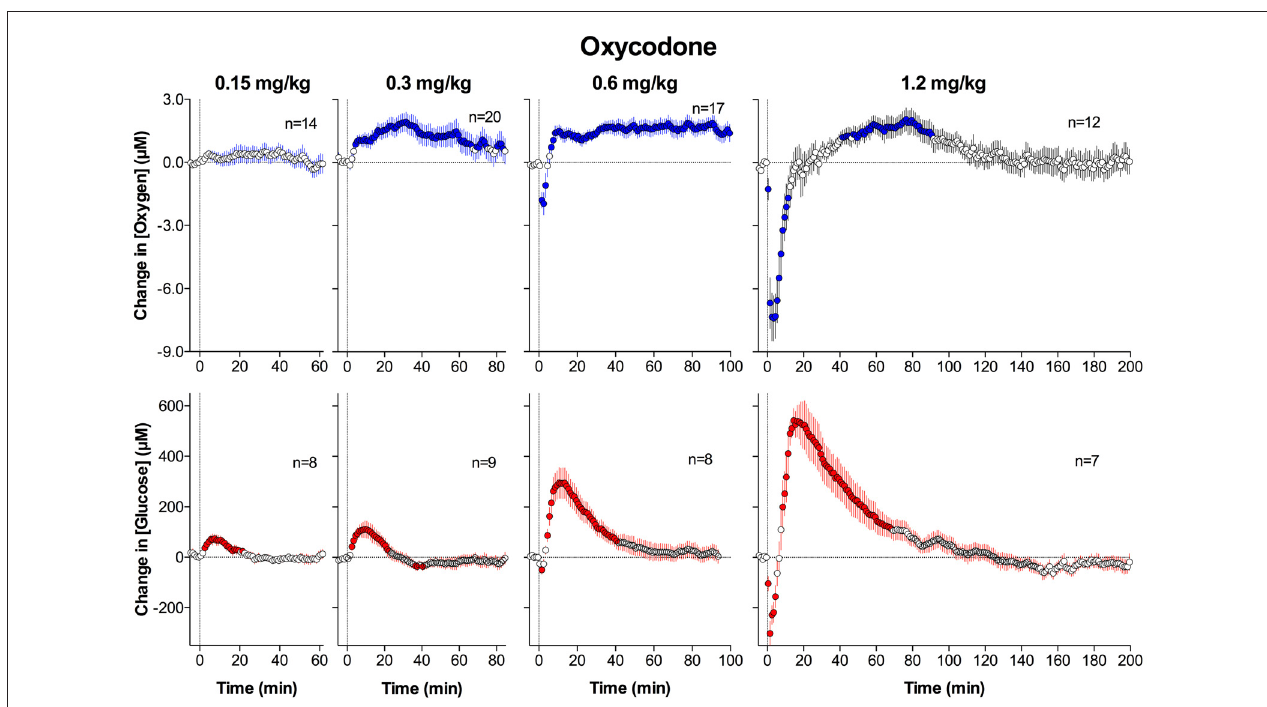
FIGURE 9 | Mean ( ± SEM) changes in NAc levels of oxygen (top graphs) and glucose (bottom graphs) induced by intravenous injections of oxycodone at four different doses. Data were analyzed with slow, 1-min time resolution and they are expressed as absolute concentration change. Values significantly different from baseline are shown as filled symbols. Vertical hatched lines show onset of injection. n indicates the number of averaged tests. Original data were published in Solis et al.